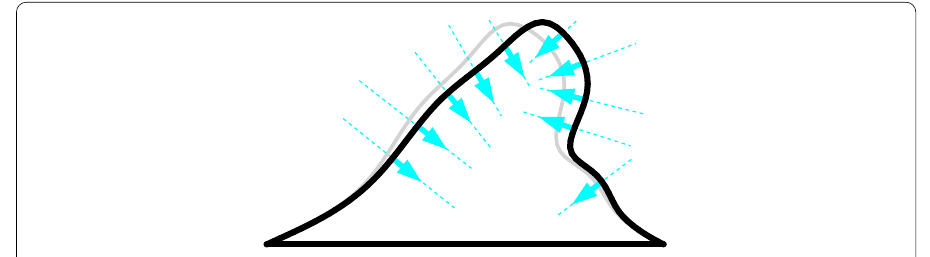
Fig. 16 Measurement points and directions as arrows indicating the positive directions for poroelastic biofilm example on the edges of the deformed geometry of the reference result (black) and initial geometry (gray)